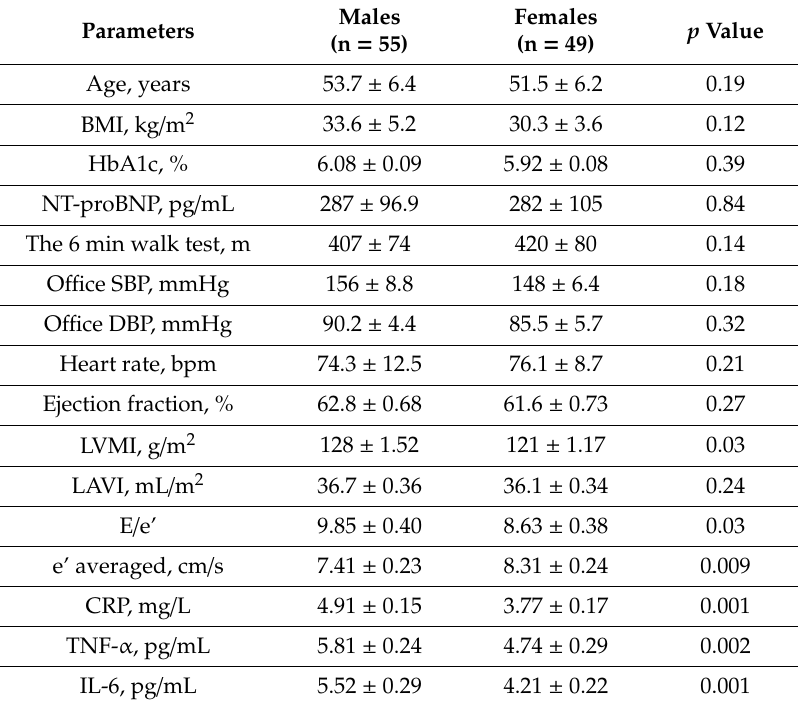
Table 1. The baseline characteristics of the examined patients with EH complicated by CHF with preserved LV systolic function (M ± std.